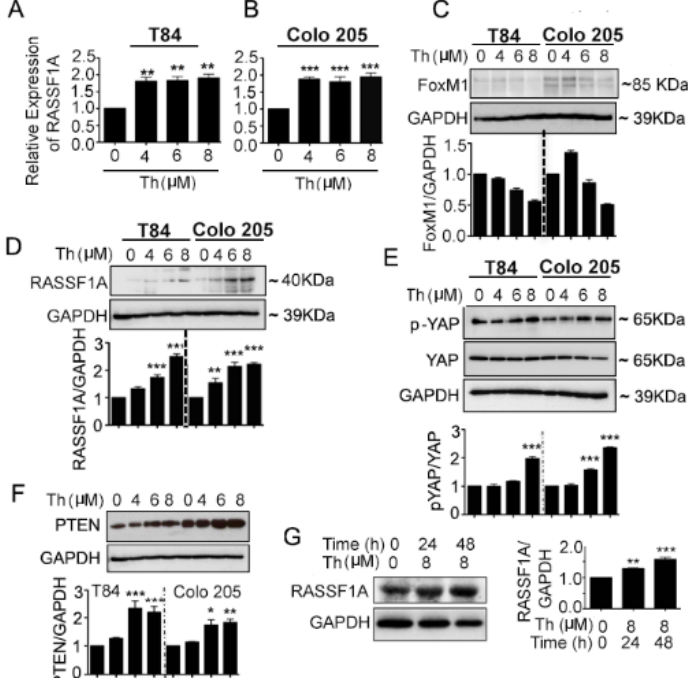
Figure 5. FoxM1 inhibitor induced RASSF1A and PTEN expression and YAP phosphorylation in mCRC cells. T84 and Colo 205 cells were treated with FoxM1 inhibitor, thiostrepton (Th) with different doses (0–8 µ M) for 48 h. ( A , B ) mRNA was extracted after 24 h for detection of RASSF1A by qRT-PCR. Bar graphs show quantitative results normalized to GAPDH mRNA levels. Cell lysates were monitored by immunoblot for FoxM1( C ), RASSF1A ( D ), p-YAP and total YAP ( E ), PTEN ( F ), and GAPDH as indicated. Immunoblots were quantified by scanning densitometry and normalized against GAPDH expression (lower panels of ( C – E ) for FoxM1, RASSF1A and p-YAP, respectively. Right panel of ( F ) represents the quantification of PTEN). ( G ) Patient derived organoids were treated with (8 µ M) and without thiostrepton for 24 h and 48 h. Organoid cell lysates were analyzed by immunoblot for RASSF1A expression and quantified by densitometry (( G ), lower panel). The results are from three independent experiments. (* p < 0.05, ** p < 0.01, *** p < 0.001).